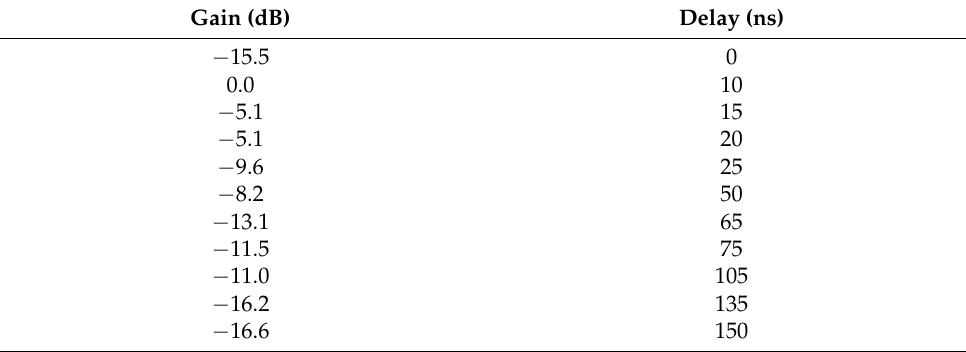
Table 3. TDL model used in macrocells and picocells.